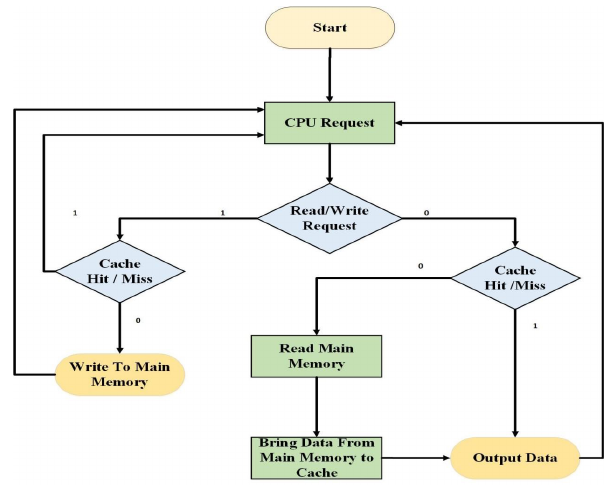
Figure 6. Flow chart of cache